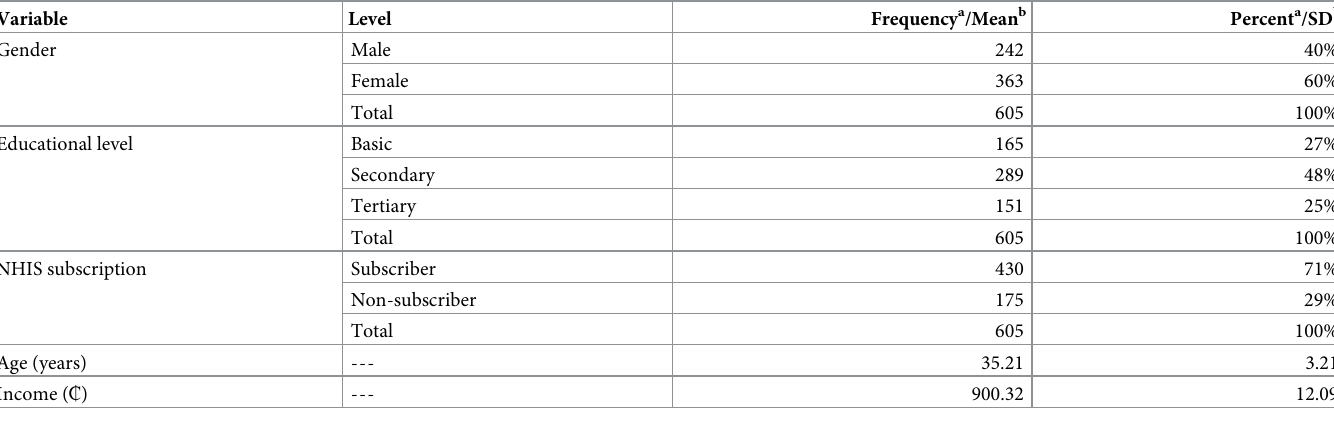
Table 2. Summary statistics on patient characteristics ( n = 605).